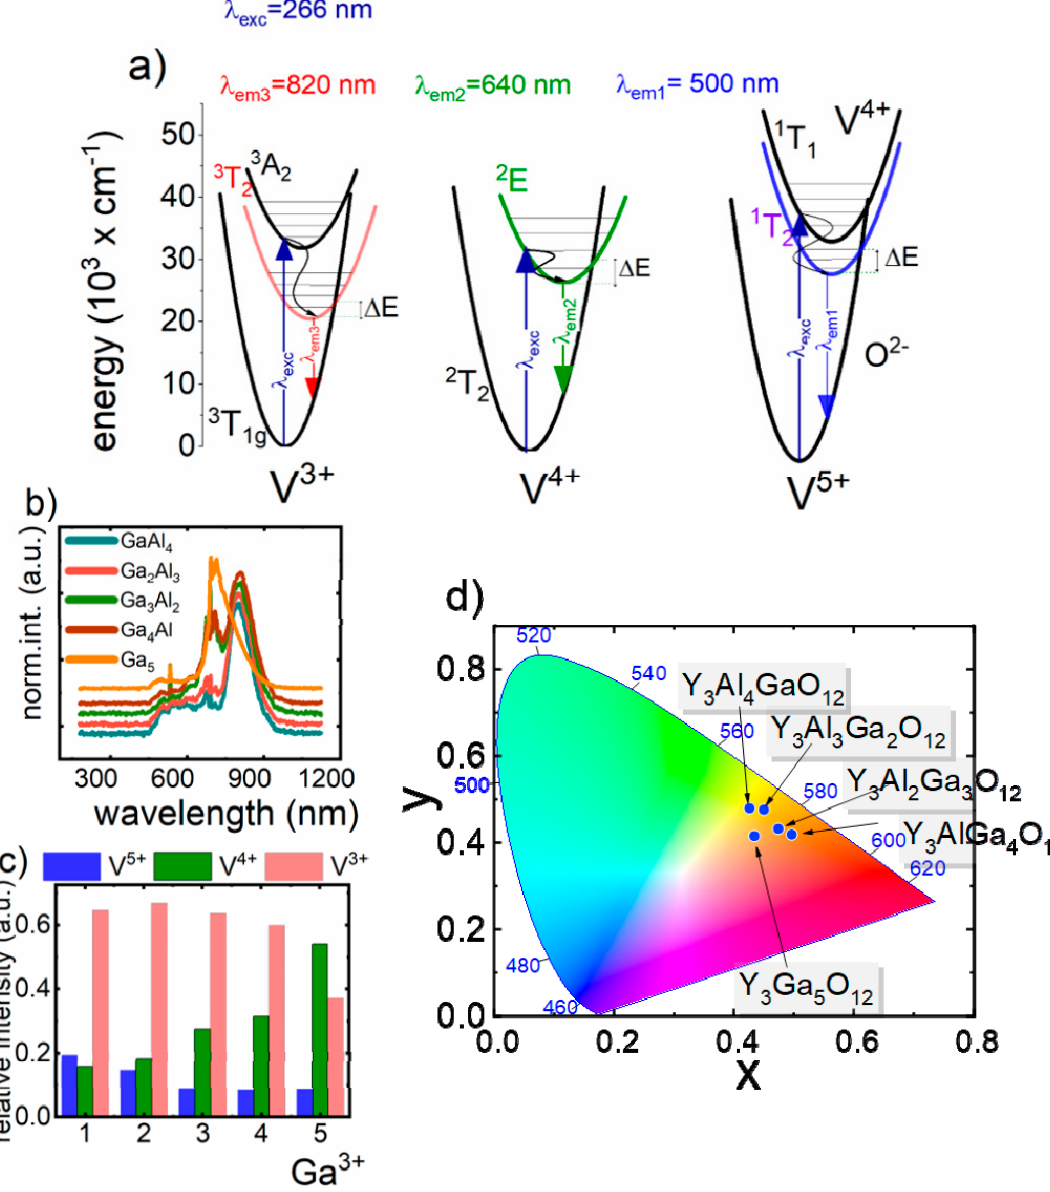
Figure 2. ( a ) The energy diagram of V ions at different oxidation states; ( b ) the influence of Ga-doping on the V emission spectrum (at − 150 °C under 266 nm) in Y 3 Al 5 − x Ga x O 12 nanomaterials at 0 °C; ( c ) the contribution of emission intensity of particular oxidation state of V ions into the overall emission spectrum of V-doped Y 3 Al 5 − x Ga x O 12 nanocrystals; ( d ) the Commission internationale de l'éclairage CIE 1931 chromatic coordinates calculated for V:Y 3 Al 5 − x Ga x O 12 nanocrystals at 0 °C.